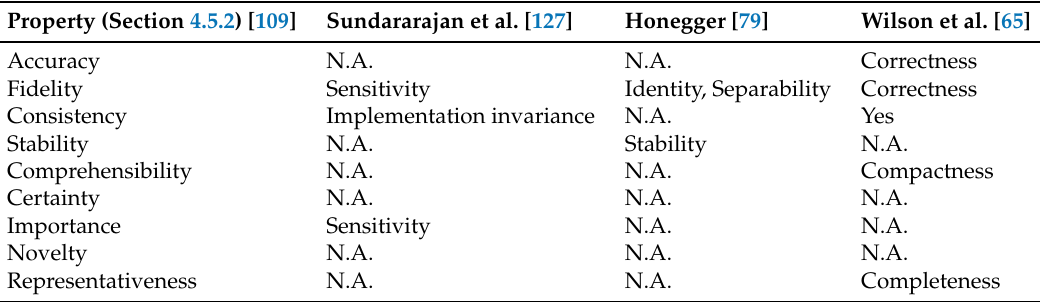
Table 6. Association between explanation properties and quantitative interpretability indicators. Property (Section 4.5.2)